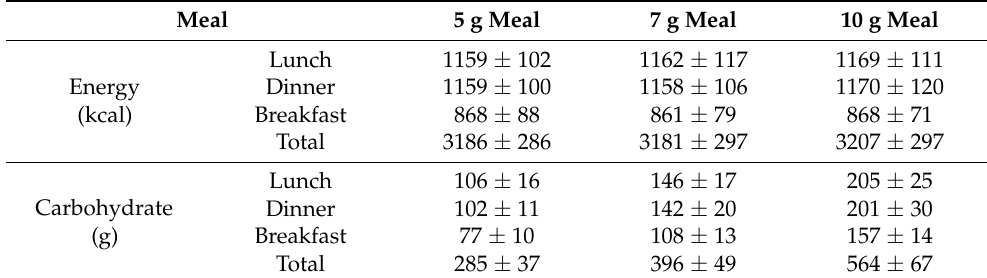
Table 1. Energy and macronutrients (carbohydrate, fat and protein) contents of the experimental meals. Values are expressed as means ± standard